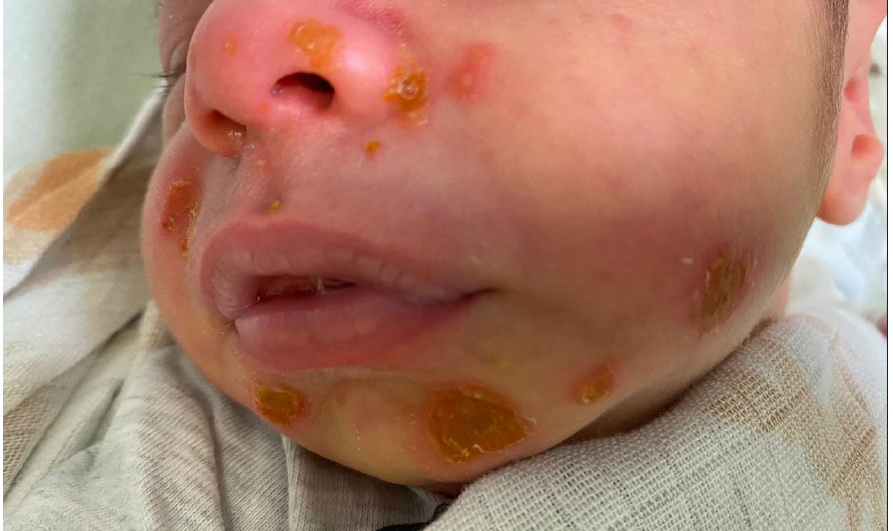
Figure 1. Erosions in a Staphylococcal bullous impetigo in a